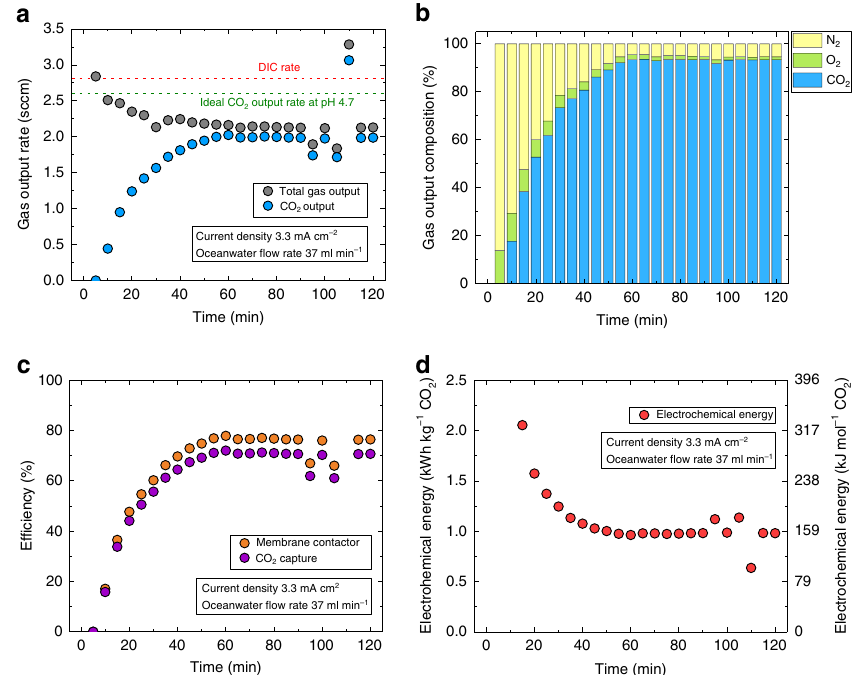
Fig. 4 CO 2 capture performance. CO 2 capture performance as a function of time at an operating current density of 3.3 mA cm − 2 and an oceanwater fl ow rate of 37 ml min − 1 (pH 4.7). a The experimentally measured total gas output rate and the captured CO 2 output fl ow rate. The red dashed line indicates the DIC rate at the given oceanwater fl ow rate and the green dashed line indicates the ideal rate of CO 2 output at these operating conditions. b The output gas composition. c The CO 2 capture and membrane contactor ef fi ciency. d The electrochemical energy